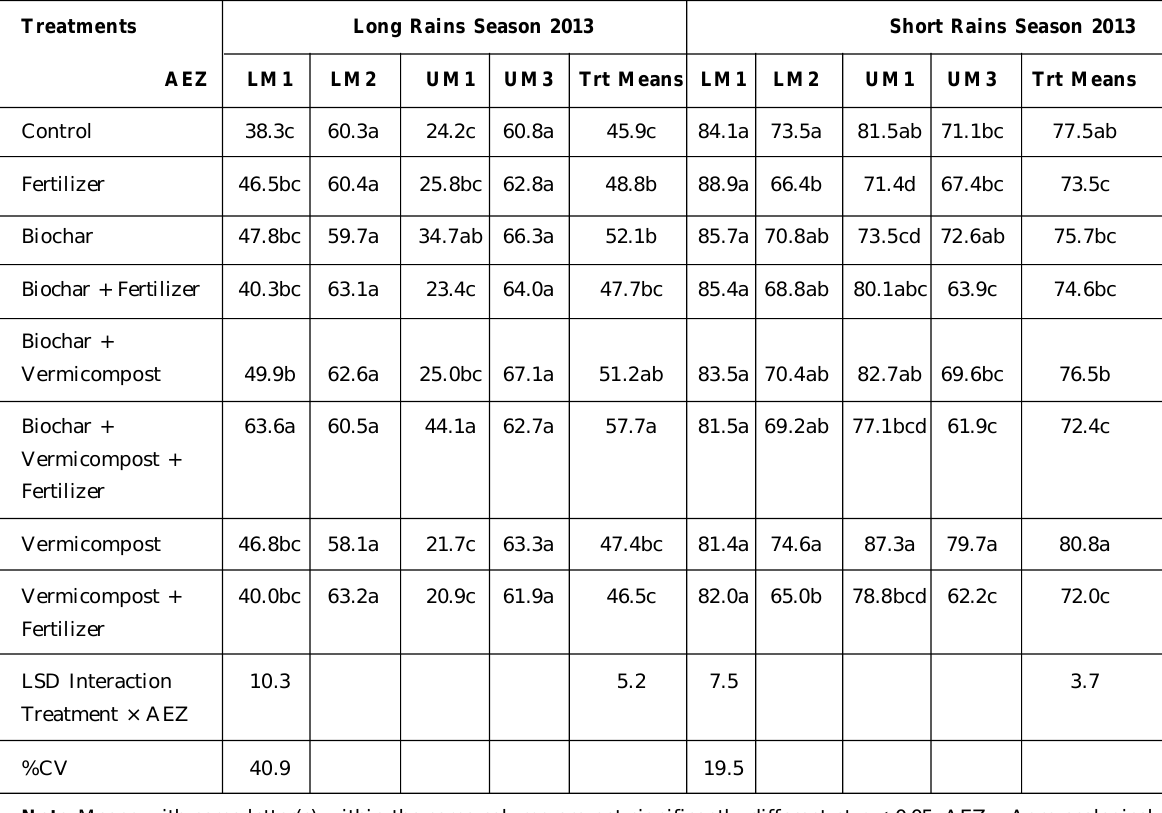
Table 3: Effect of different treatments on plant emergence (%) in different AEZ’s of Western Kenya during the long rains and short rains seasons of